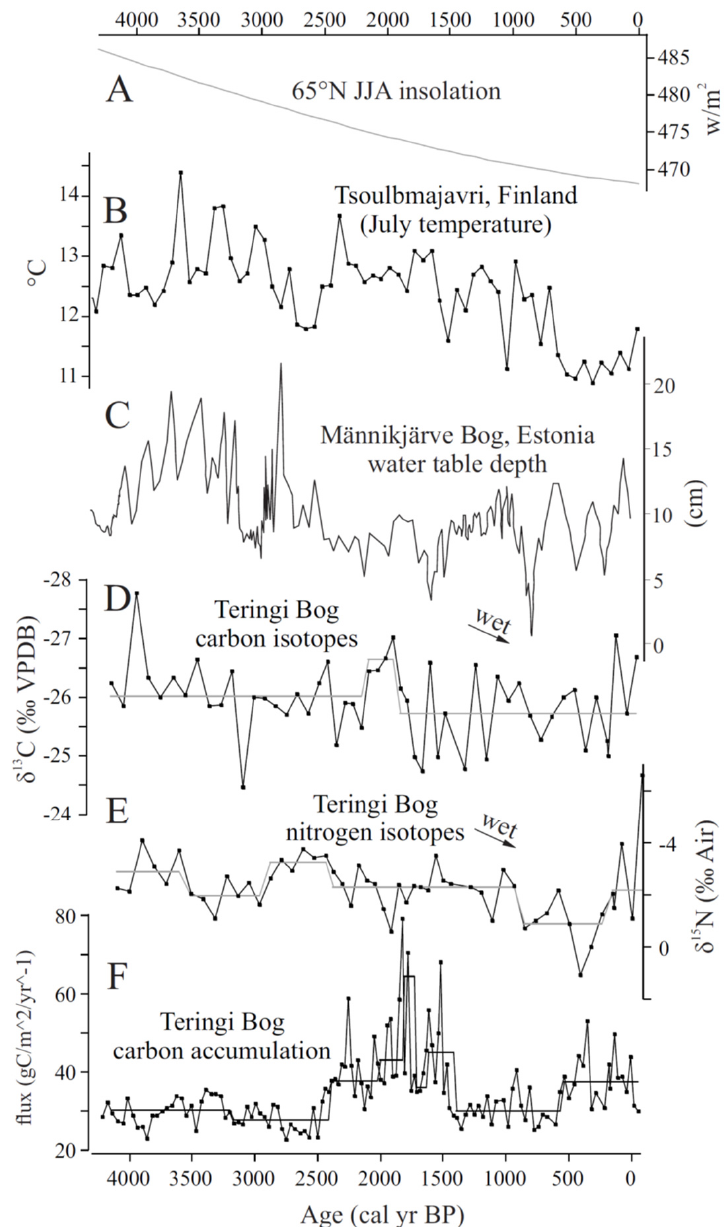
Figure 9. Teringi Bog data plotted versus regional paleoclimate records mentioned in text. Summer insolation ( A ) [21] decreased through the late Holocene as there was an overall trend to lower temperatures recorded in lake sediment records ( B ) [44]. Fluctuations in water table depth recorded at Männikjärve Bog in Estonia ( C ) [45] generally correspond to changes in hydroclimate recorded in the carbon ( D ) and nitrogen ( E) isotope records from Teringi Bog. Note the inverted vertical axes for δ 13 C and δ 15 N. The carbon accumulation rates at Teringi Bog ( F ) were generally higher under wetter conditions during the late Holocene.